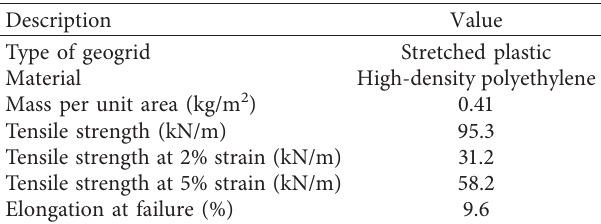
Table 3: The engineering properties of the geogrid used in the tests (manufacturer’s